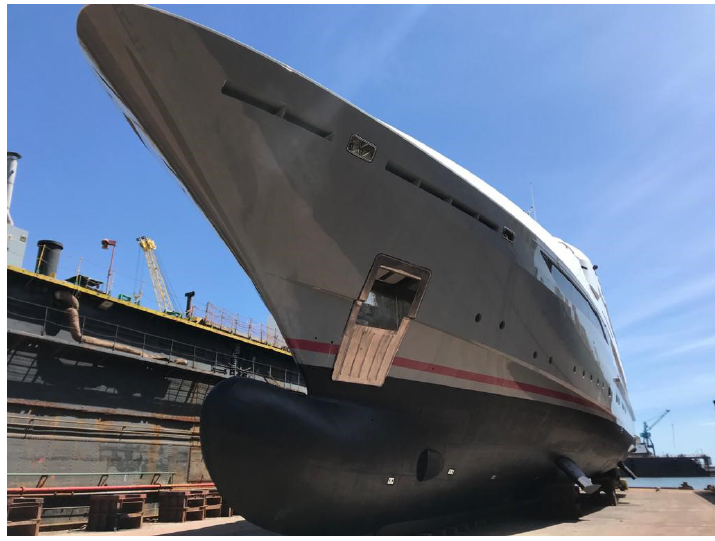
Figure 4. Conventional bow with bulb example.